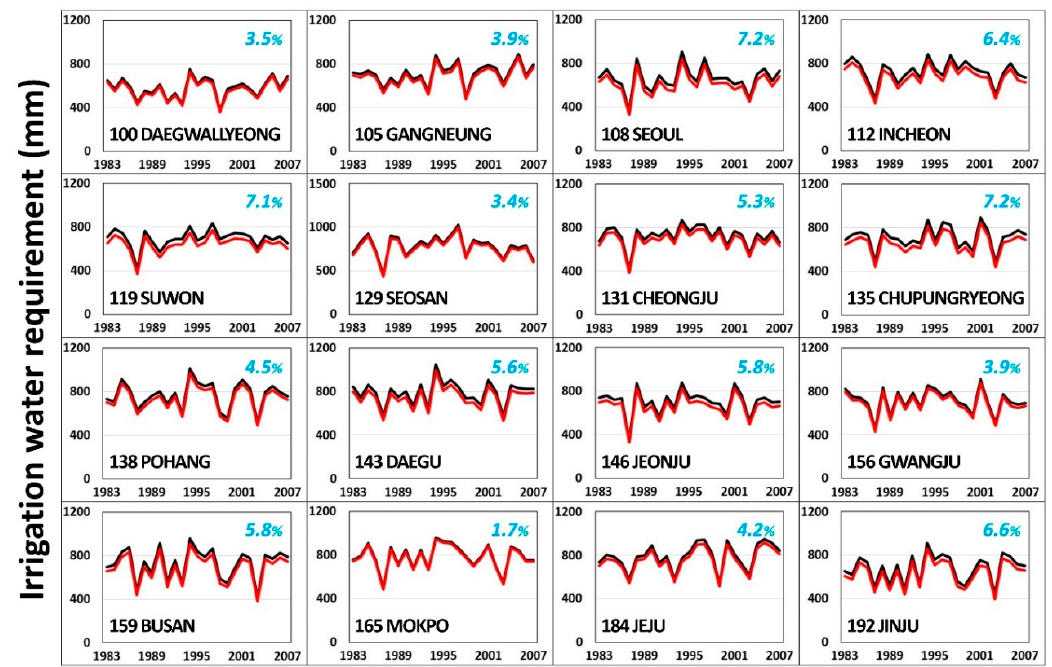
Figure 4. Estimates of the irrigation water requirement (IWR) for paddy rice using the recommended (black solid line) and calibrated A-P coefficients (red solid line) for the period 1983–2007. The average difference between the two estimates of IWR for the study period is presented as a percentage in sky blue (e.g., 3.5% for Daegwallyeong).